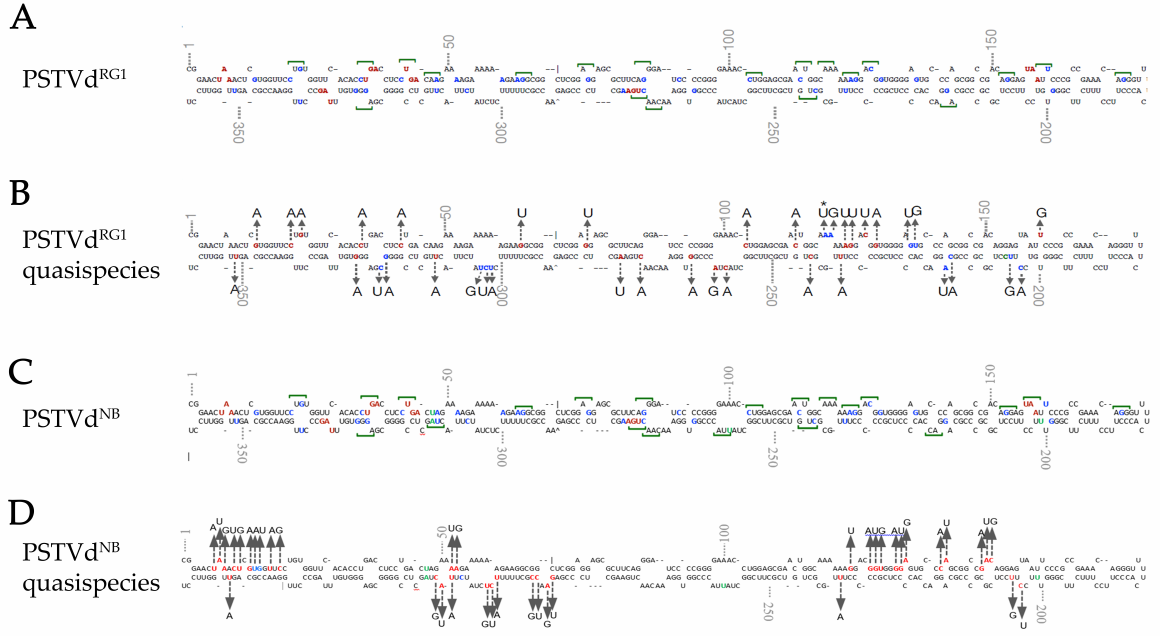
Figure 2. Identification of possible quasi-species using viroid-derived siRNA and total RNA NGS analysis. ( A , C ) To locate the potential translation start codons on the PSTVd RG1 and PSTVd NB molecule, the in silico detected alternate start codons (indicated by green line over the nucleotides), the point mutation that could lead into a start codon (blue font), and the stop codons (red font) are shown on secondary structure of PSTVd. The green letters indicate the different nucleotides between PSTVd RG1 and PSTVd NB . ( B ) Analysis of sRNA derived from PSTVd RG1 -inoculated plants revealed the presence of translation start codon (AUG) on PSTVd RG1 sequence. Location and changes in sequence variation that lead into the formation of potential start codons are shown on the secondary structure of PSTVd RG1 . The red font indicates the nucleotide that was changed during infection. The two or three mutations that led into the formation of AUG are shown by blue font and an asterisk (*) indicates the nucleotide that showed both point mutation and double mutation. ( D ) Colors represent the same as in B but for PSTVd NB . However, only the mutations with the higher percentage range per position are represented in this figure (described in Table